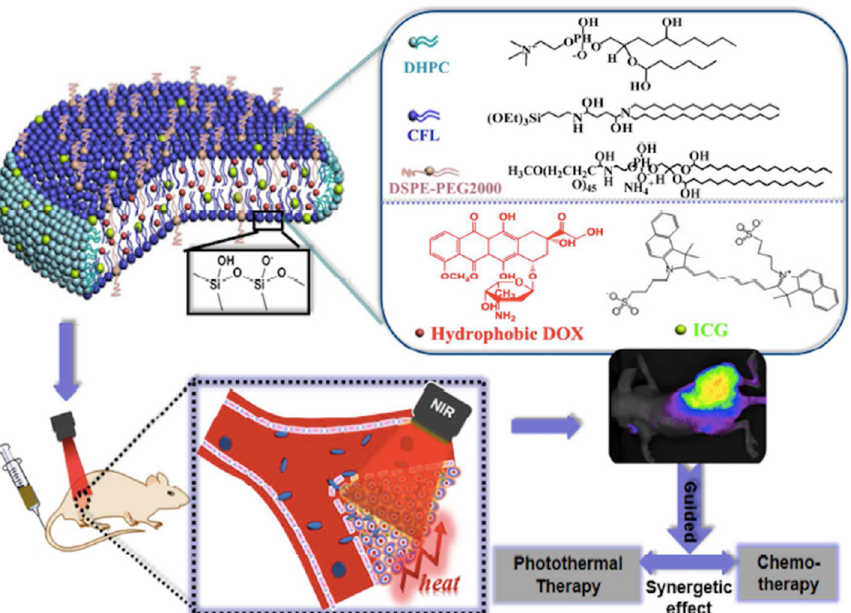
Figure 5. Schematic illustration of the bicelle containing doxorubicin (DOX) and fluorescent dye. Reprinted with permission from ref 88. Copyright 2017 American Chemical Society.